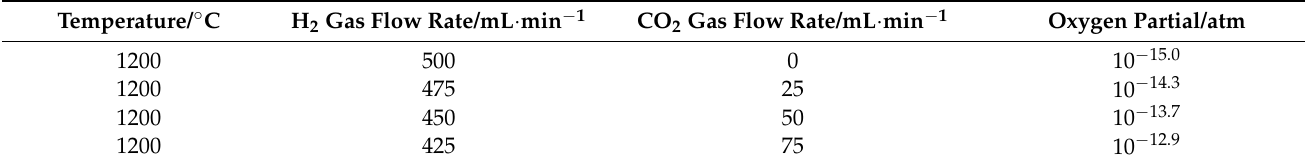
Table 2. Oxygen partial pressure measurement results at 1200 ◦